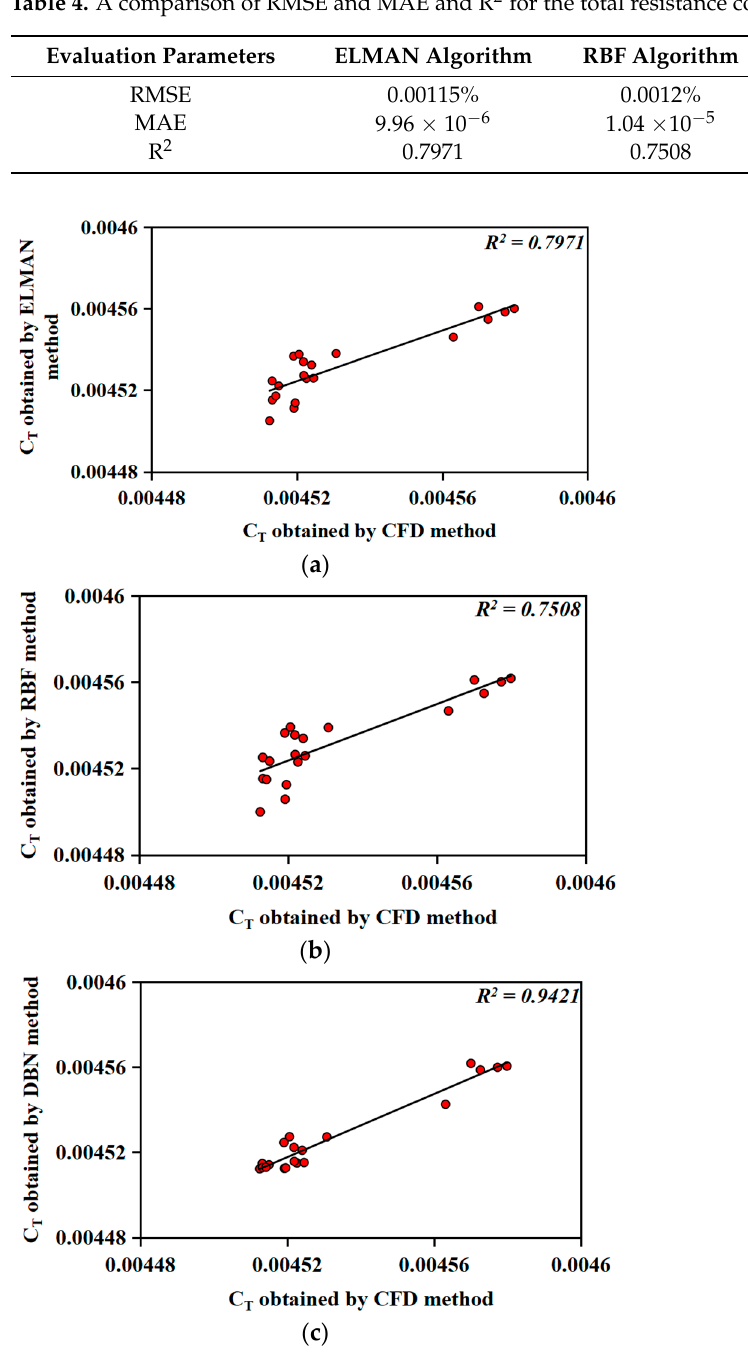
Figure 11. Error analysis for R 2 using different surrogate models. ( a ) Error analysis for R 2 using the ELMAN surrogate model. ( b ) Error analysis for R 2 using the RBF surrogate model. ( c ) Error analysis for R 2 using the DBN surrogate model.